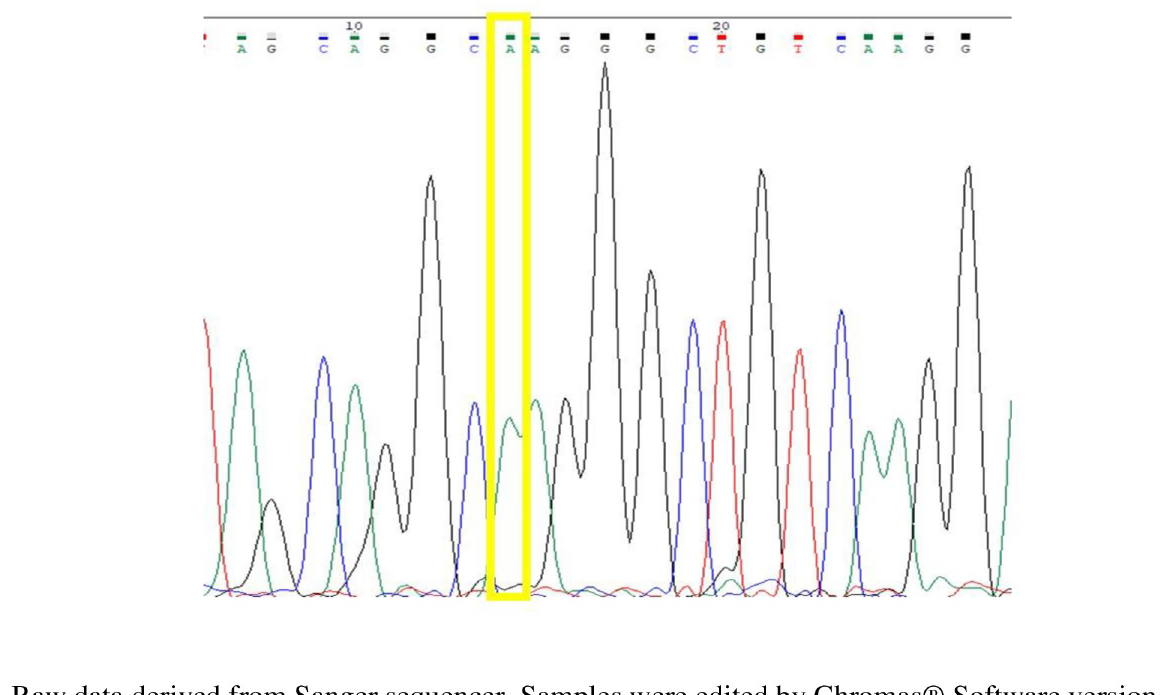
Fig 3. Sample of chromatogram data of rs10741657 showing the SNP- A allele in location 14 bp.